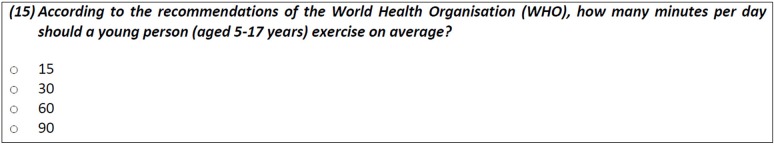
Example for a single choice item of the standardized paper and pencil test.